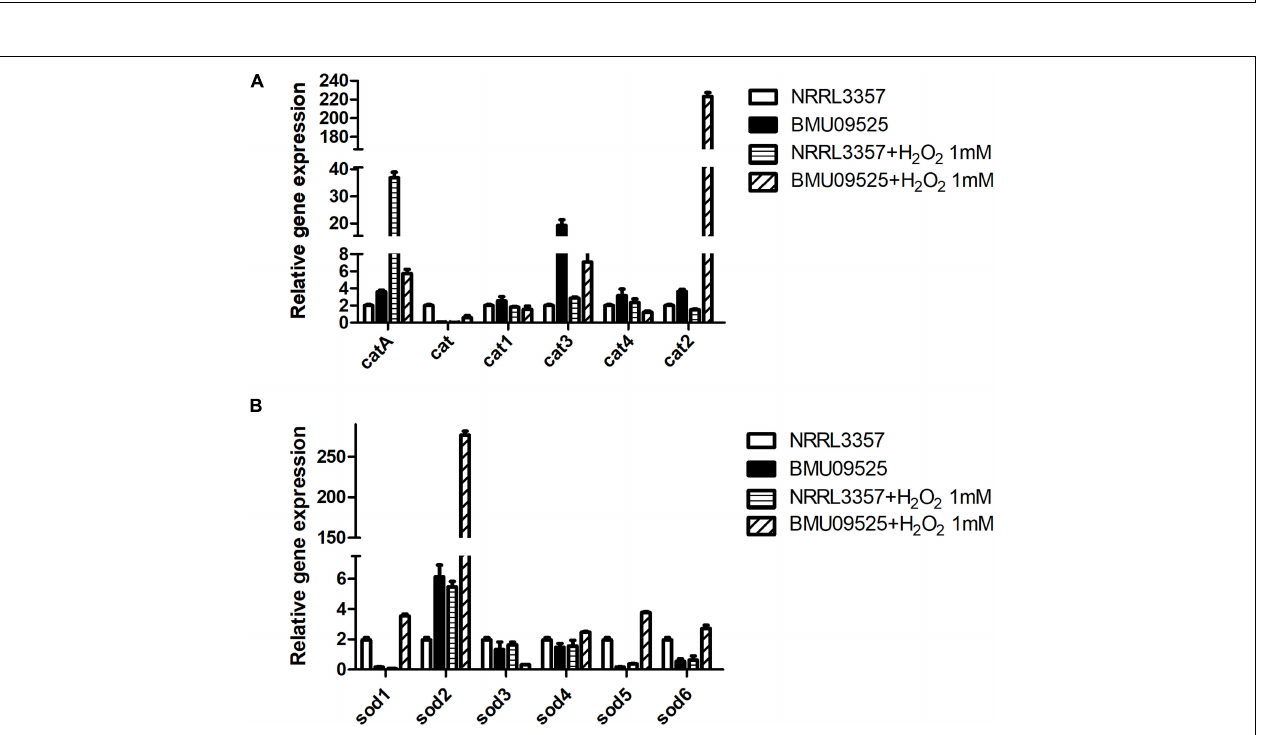
FIGURE 5 | The expression level of (A) cat genes and (B) sod genes in A. flavus . A total of 1 × 10 6 CFU A. flavus conidia were preincubated in Aspergillus minimal medium for 18 h at 37 ◦ C and 200 rpm before H 2 O 2 (1 mM) was added for 2 h. Then the hyphae were harvested and total RNA was extracted following liquid nitrogen crush. Gene expression was normalized to that of beta-tubulin according to the 2 - (cid:49)(cid:49) Ct method. Data are presented as means ± standard deviations for three independent experiments with technical duplicates.